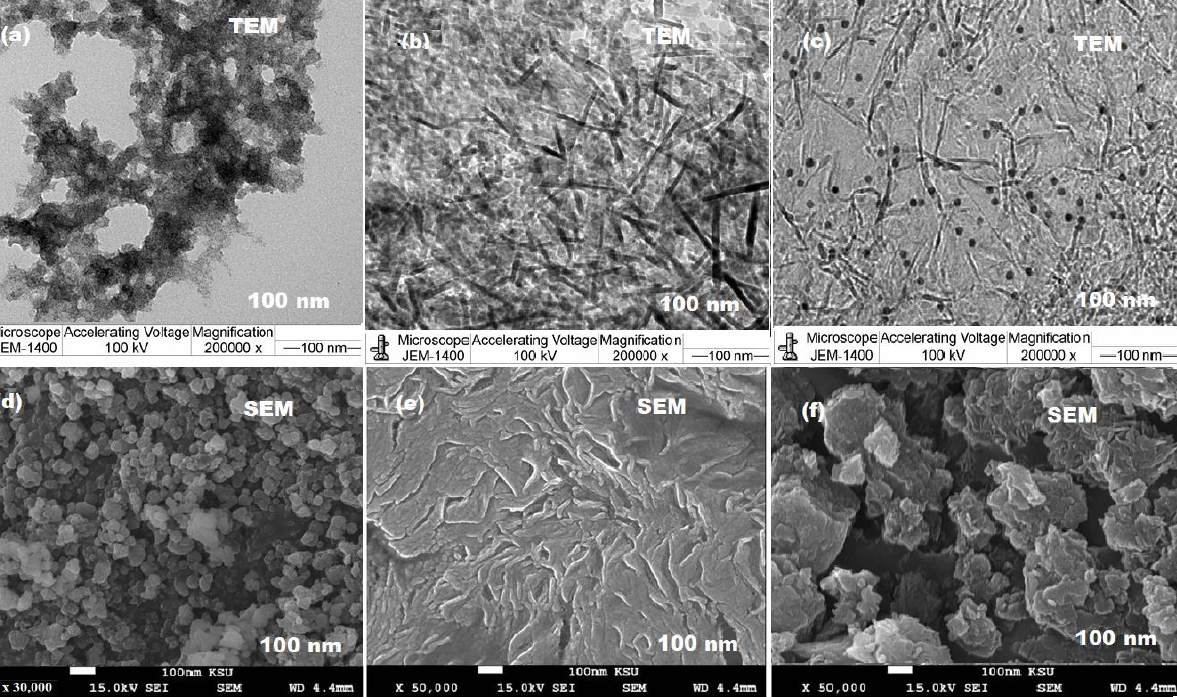
2 O 3 NPs and CuO/Al 2 O 3 nanocomposite,